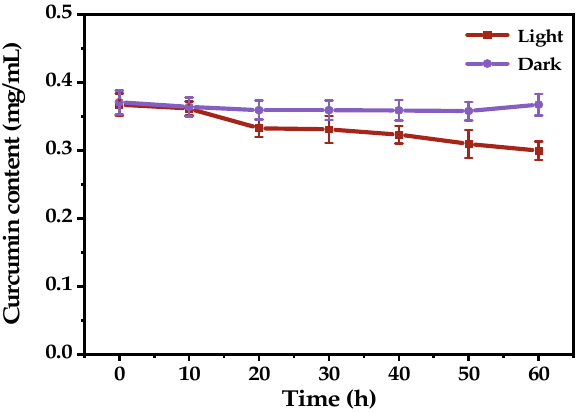
Figure 10. Curcumin content variation as a function of storage time.